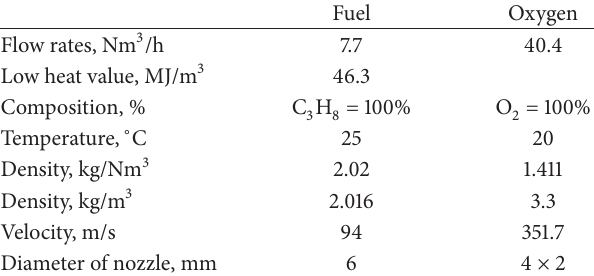
Table 3: Boundary condition of the inlet